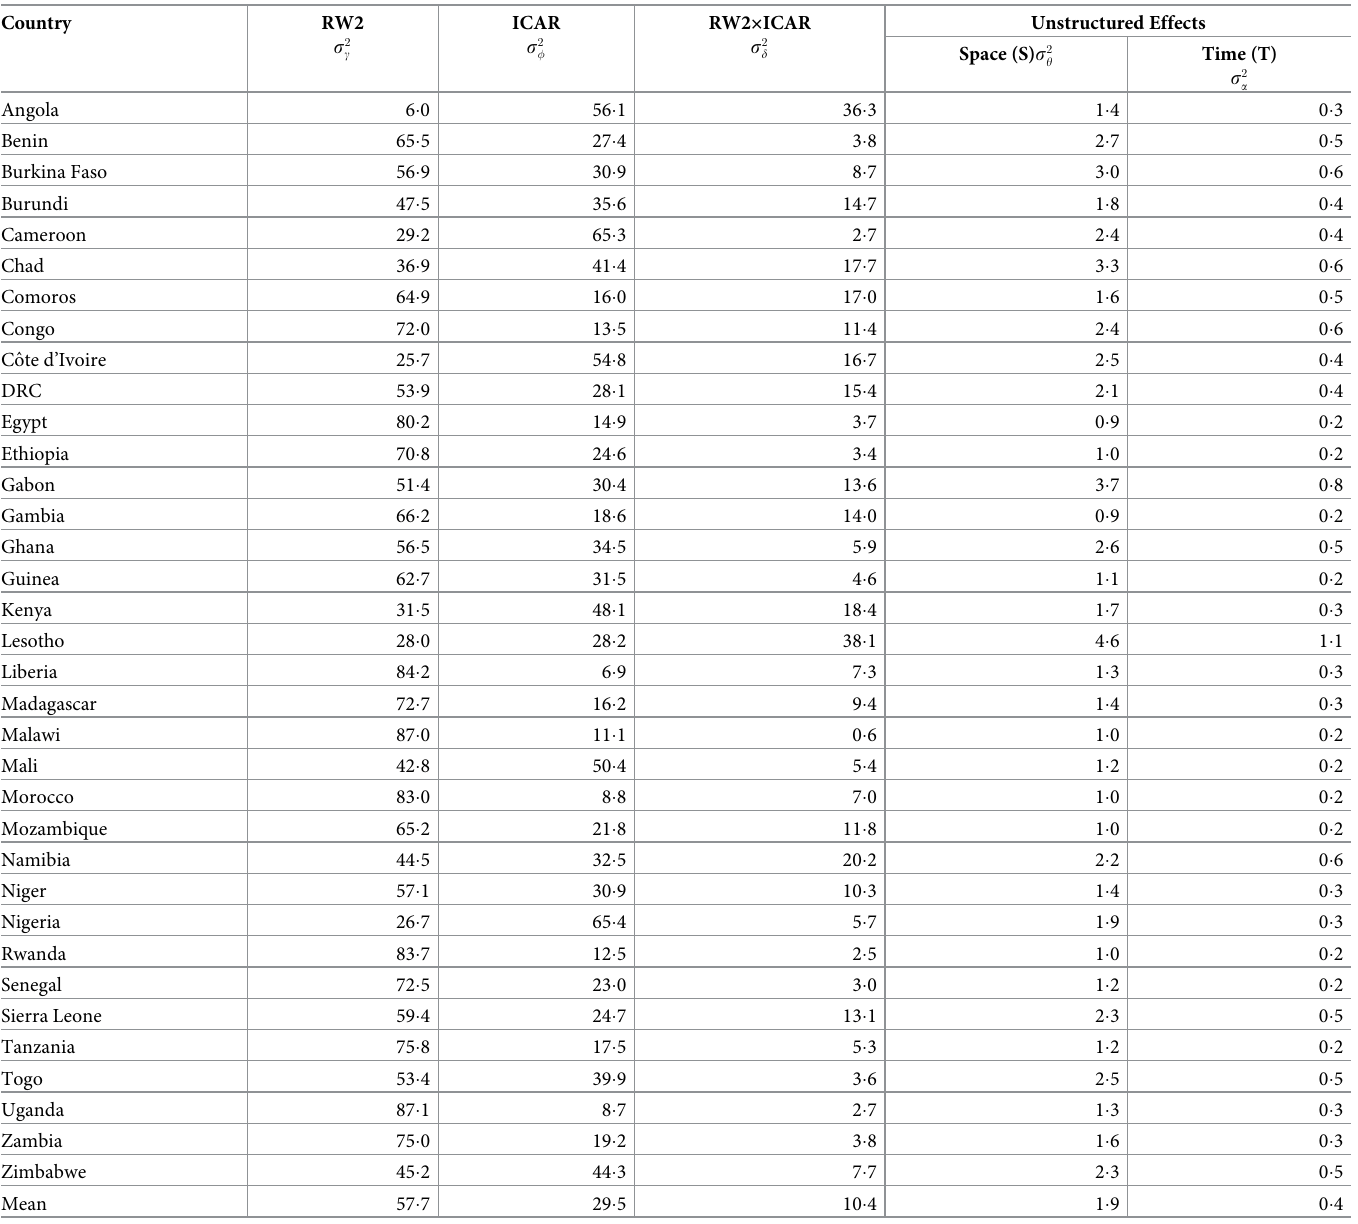
Table 1. Variance component proportions